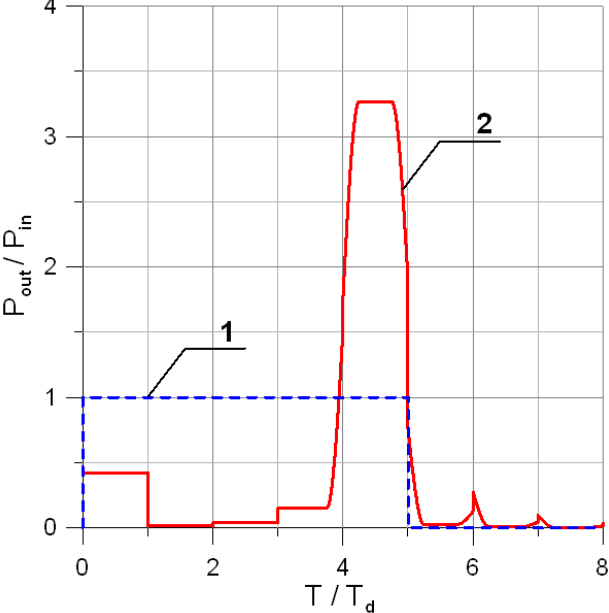
FIG. 13. (Color) Calculated envelope of the input (1) and output (2) pulses for the one-channel SLED-II with phase reversal switch time of 50 ns, (cid:2)